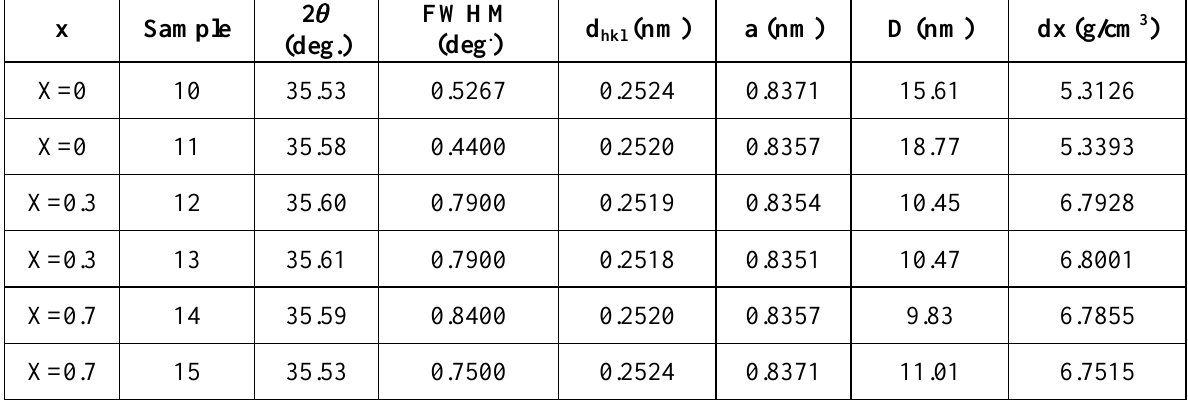
Table 2: XRD pattern analysis of the rest Co spacing between crystal plans, lattice constant, average crystallite size and density of powder.